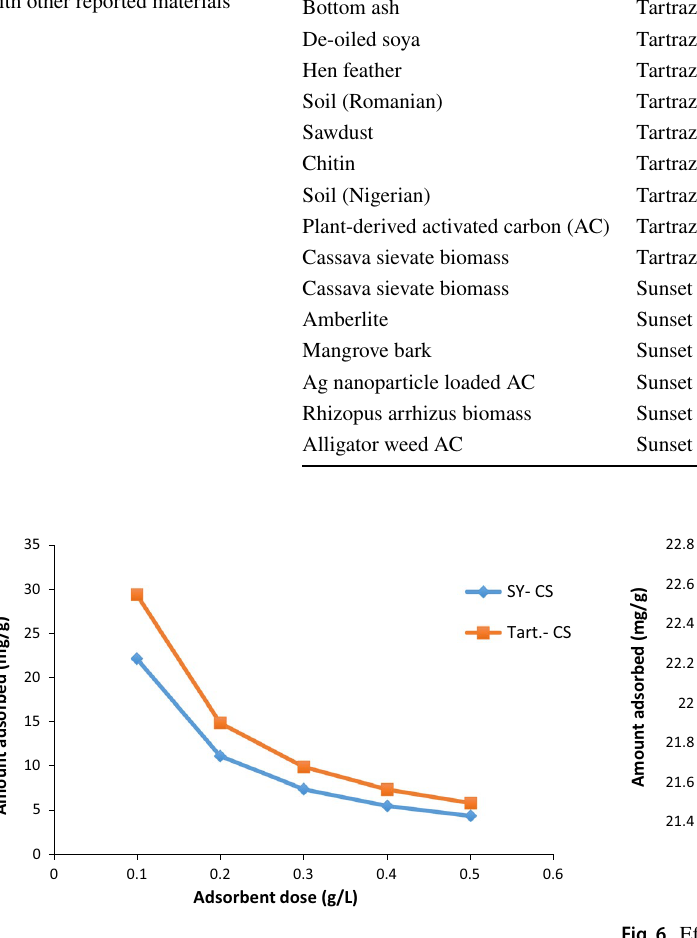
Fig. 5 Effect of adsorbent dose on the amount of sunset yellow and tartrazine dyes adsorbed unto cassava sievate